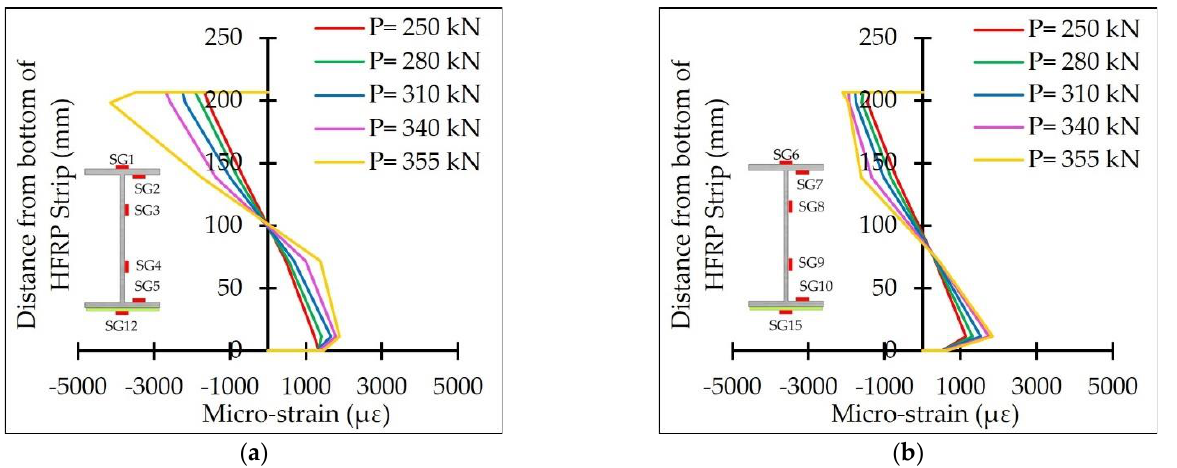
Figure 19. Strain profile of 1170-S-100 at different loads at: ( a ) mid-segment; ( b ) edge-segment. Comparing the tensile strains of 1620-S-100 at the mid-segment and the edge-segment in Figure 20 indicates a lower level of composite action at the edge-segment. This implies higher stress concentrations near the HFRP edge, reflecting a similar behavior to the de- bonding process that typically initiates at the FRP edge in bonded FRP-steel beams, as reported in earlier studies [16,38,40,42,43]. Reducing the number of the fastening bolts by decreasing the length of the HFRP strip had a negative effect on the level of composite action of the fastened components, as shown by comparing the tensile strains of 1620-S-100, 1170-S- 100 and 810-S-100 in Figure 21. Linear strain distributions were plotted at the mid-segments of 1620-S-100 and 1170-S-100 before steel yielding. Although the HFRP strains of 1620-S-100 after yielding were higher than the steel strains, lower HFRP strains were recorded on beam 1170-S-100 due to the reduced HFRP length. Further reduction in the HFRP length resulted in an early loss in the composite action of the fastened materials, as evidenced by the lower HFRP strains at a load of 150 kN in beam 810-S-100 (refer to Figure 21c). Thus, the distribution of the tensile strains over the cross-section of the strengthened beams highlights three main trends. Linear strain distribution with full composite action was attained before yielding by utilizing a proper number of bolts that enables full compatibility at the steel-HFRP interface. A bi-linear strain distribution with higher HFRP strains was reported after steel yielding in configurations with a proper number of bolts. Finally, a when the HFRP experienced high concentrations of the bearing stresses.